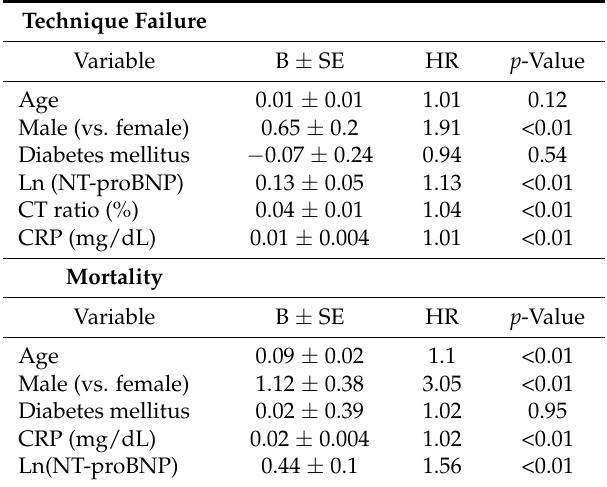
Table 4. Cox proportional hazard regression analyses with technique failure and mortality as the dependent